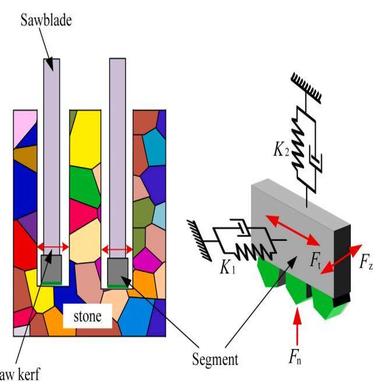
The schematic diagram of a segment dynamic model.